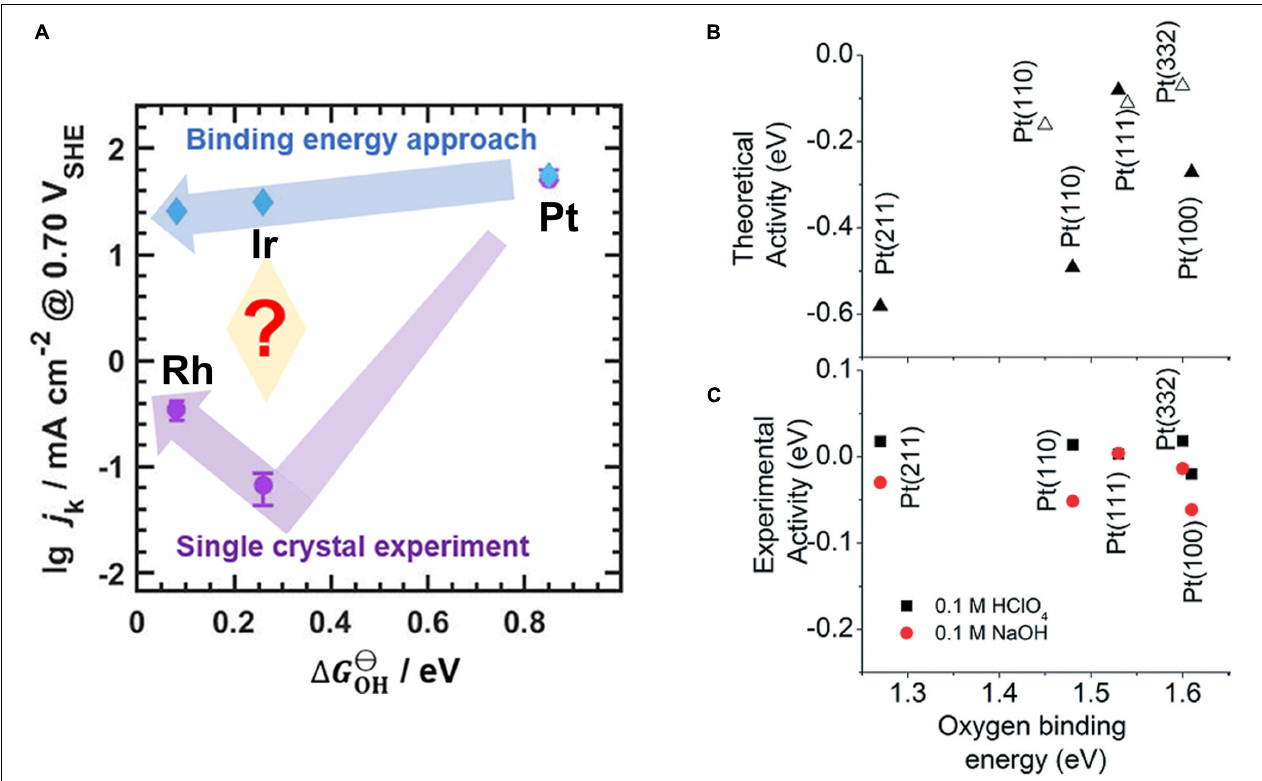
FIGURE 6 | (A) Theoretical (blue) and experimental (purple) ORR activity trends on Pt, Ir, and Rh single-crystal (111) rotating disk electrodes. (B,C) A theoretical and experimental volcano plot of ORR on different facets of platinum. Reproduced from Zhou et al. (2020) and Gómez-Marín et al. (2014) with permission. Copyright 2020 American Chemical Society, 2014 Royal Society of